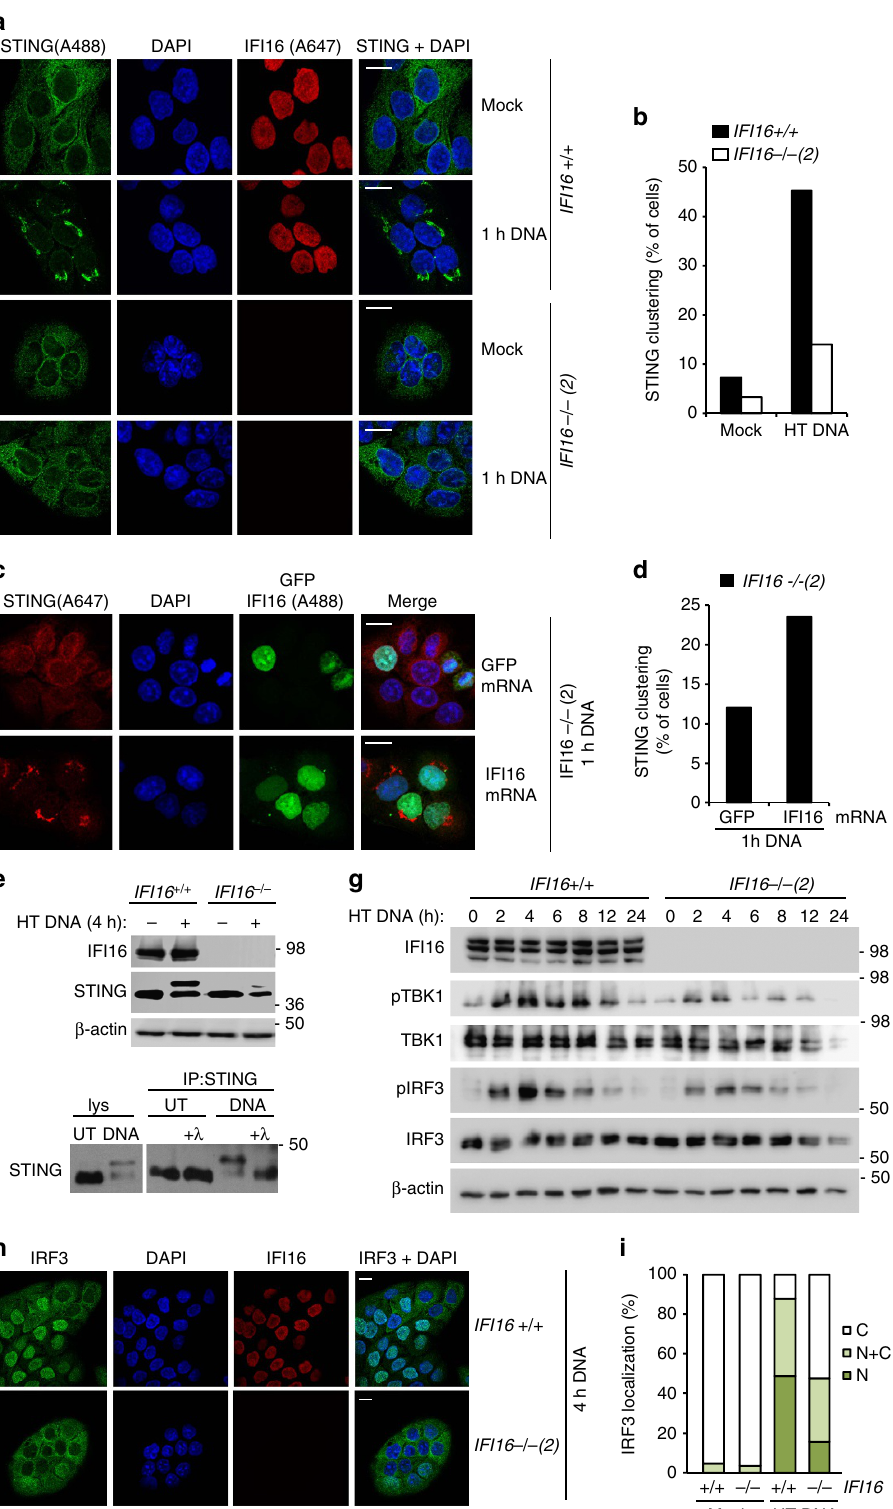
Fig. 4d). Following stimulation with HT DNA or VACV 70mer oligonucleotide, cGAMP levels increase in both wild-type and IFI16-deficient HaCaT cells (Fig. 5e,f and Supplementary Fig. 4e). Treatment of cell extracts with snake venom phospho- diesterase removes the cGAMP peak following DNA